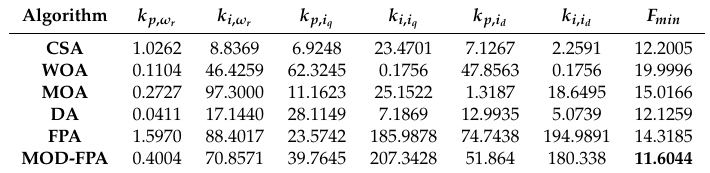
Table 4. Optimal value for PI controller gains using CSA, WOA, MOA, DA, MOD-FPA and